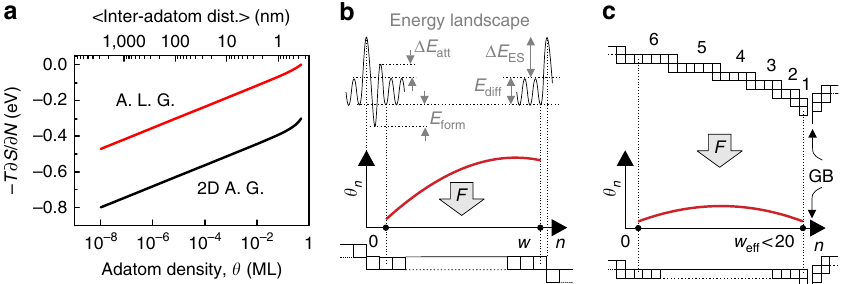
Figure 2 | Surface CP on terraces and next to GBs. ( a ) Entropic component of the CP on Cu(111), estimated by the adatom lattice gas and the 2D adatom gas model. ( b ) Adatom density profile, y n , on a terrace; the corresponding energy landscape is indicated on the top. ( c ) Typical step configuration in the vicinity of a GB caused by the Zeno effect (top). As D E ES vanishes for terrace widths with w o 6, the combination of these terraces can be approximated with one effective terrace (bottom). This leads to a lower adatom density near the GB and, therefore, to lower stresses. dist., distance. NATURE COMMUNICATIONS|7:10733|DOI: